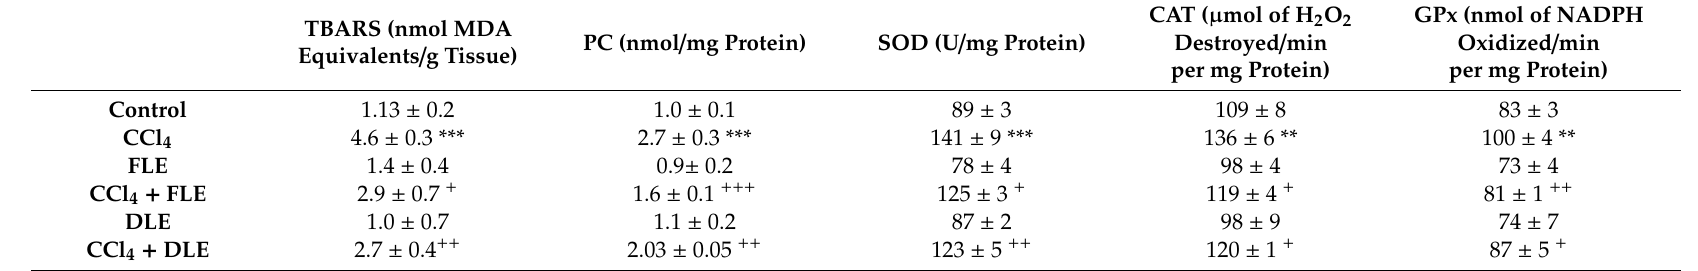
Table 3. E ff ect of CCl 4, FLE and DLE on liver oxidative